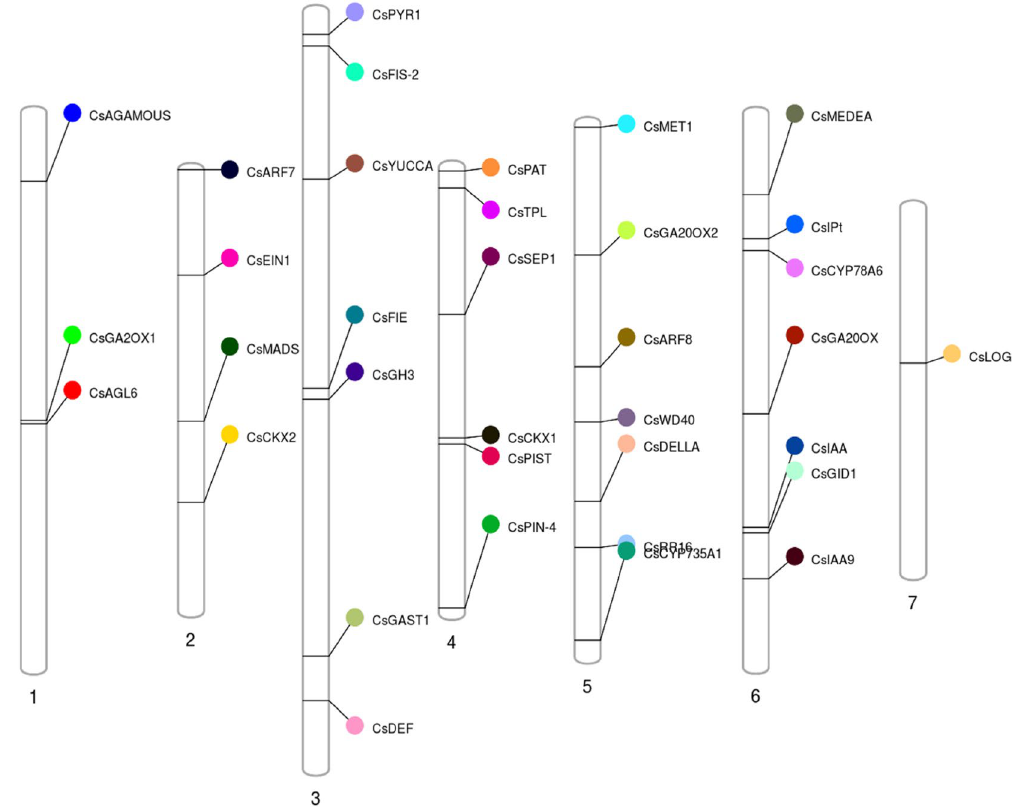
Figure 1. Graphical (scaled) representation of physical locations for parthenocarpy genes on cucumber chromosomes (numbered 1–7). Different colours of circles represent different